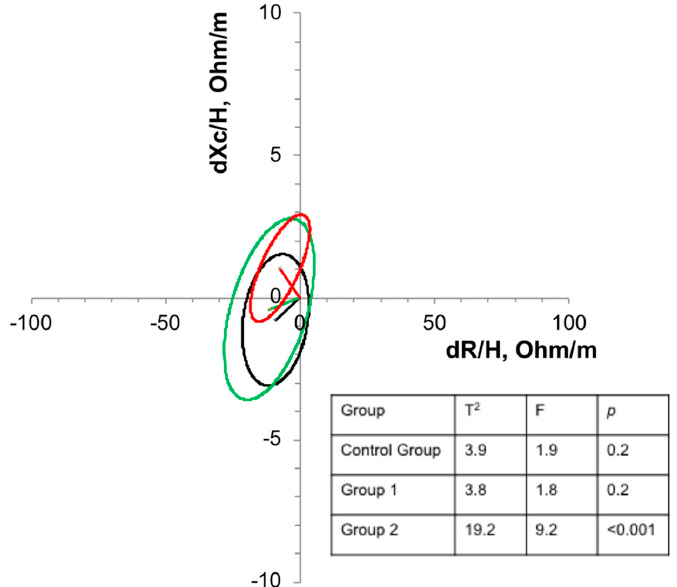
Figure 3. Confidence ellipses of 95% of impedance vectors measured before (T0) and after (T1) three months of intervention with oral supplementation with different concentrations of zinc in eutrophic children. Black ellipse = control group; Green ellipse = Group 1; Red ellipse = Group 2. An upward or downward displacement of the main axis is associated with more or less soft tissue cell mass, respectively.